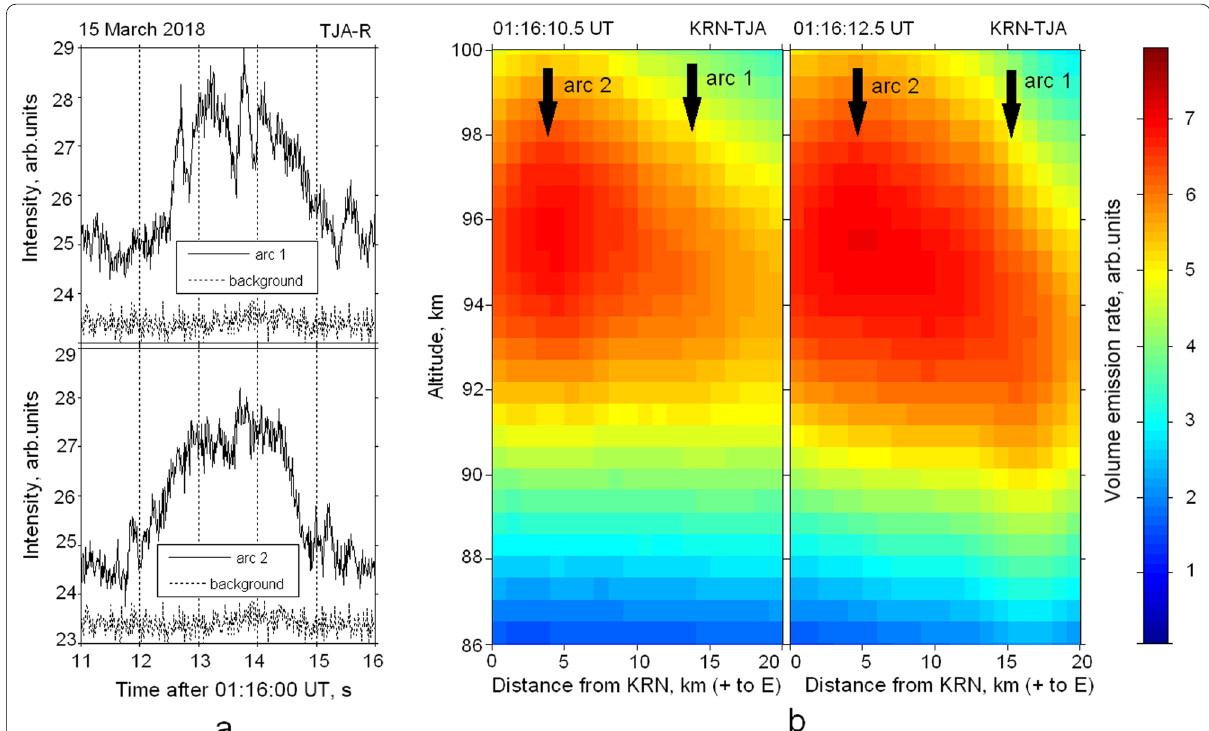
Fig. 7 a Luminosity variations in the arcs and background for the second switch‑on interval (Fig. 1b); b altitude distribution of arc luminosity before (left panel) and during (right panel) the interval